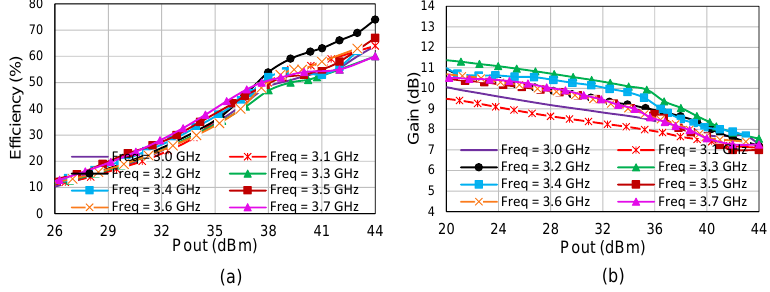
Figure 10. Measured CW performance of the DPA: ( a ) drain efficiency and ( b ) gain.